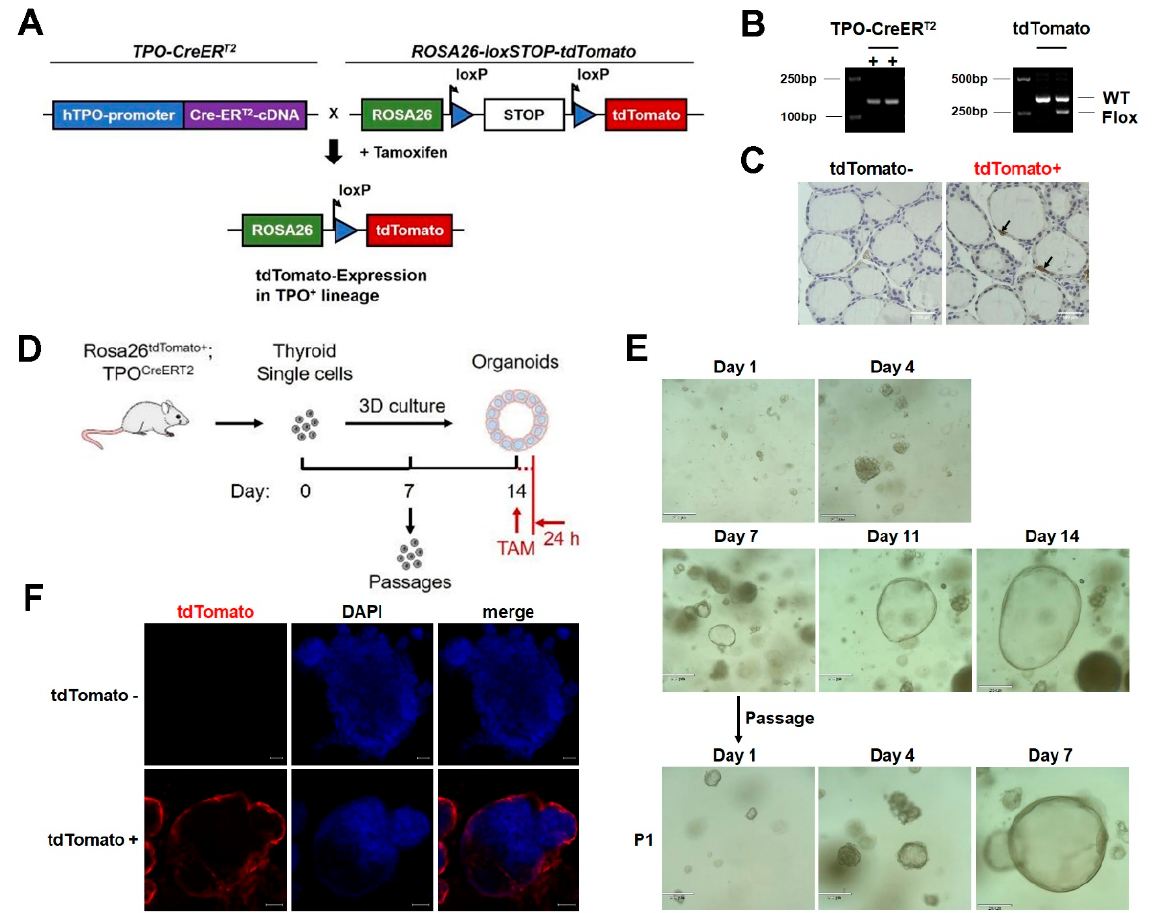
Figure 2. Three-dimensional (3D) culture enables the thyrocytes to form organoids with follicle-like structures. ( A , B ) Schematic diagram for the generation of Rosa26 tdTomato/+ ;TPO CreERT2/+ mice ( A ) and genotyping of Rosa26 tdTomato/+ ;TPO CreERT2/+ mice ( B ). ( C ) Representative images of tdTomato immunohistochemical staining of thyroid tissues from Rosa26 tdTomato/ − ;TPO CreERT2/+ mice and Rosa26 tdTomato/+ ;TPO CreERT2/+ mice treated with tamoxifen. Scale bars: 100 µ m. ( D ) Schematic diagram of thyroid organoids culture and passaging. TAM, tamoxifen. ( E ) Light microscopy pictures of thyroid organoids developing from a single cell over the course of 14 days (upper panel) and follicles-like structure formation capacity upon passaging in 3D culture ( n = 9). Scale bars: 210 µ m. ( F ) TdTomato immunofluorescent staining of thyroid organoids from Rosa26 tdTomato/ − ;TPO CreERT2/+ (upper panel) and Rosa26 tdTomato/+ ;TPO CreERT2/+ (lower panel) mice. tdTomato (Red); nuclear staining with DAPI (Blue). Scale bars: 50 µ